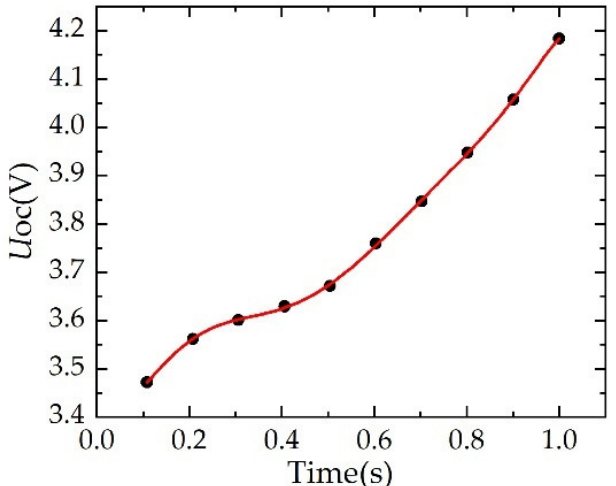
Figure 2. U OC –SOC fitting curve.